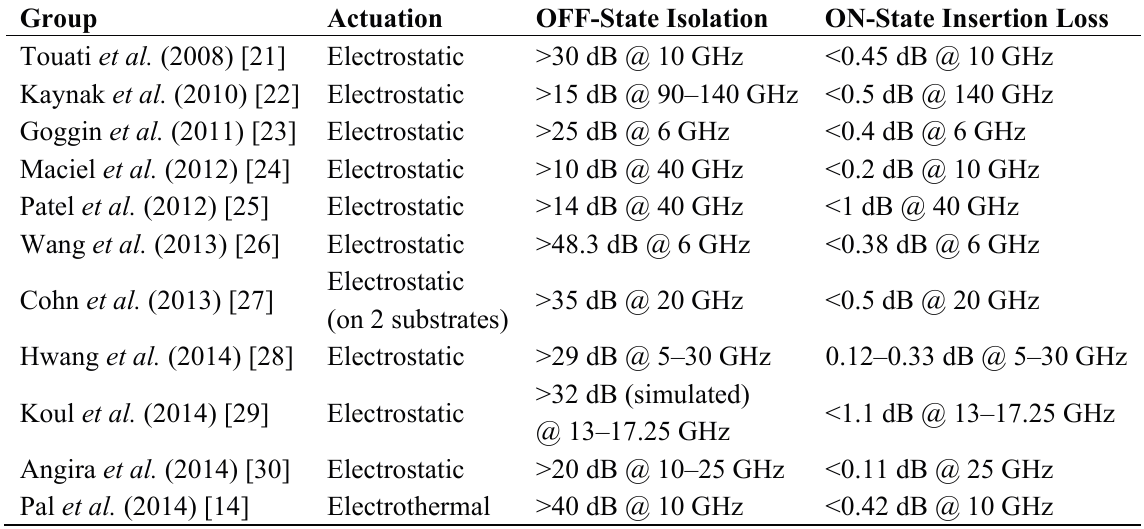
Table 1. Isolation and insertion loss parameters for recently reported MEMS